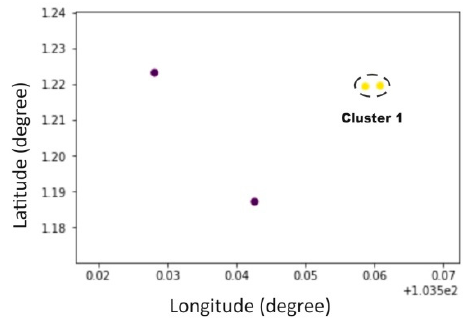
Figure 12. Result of DBSCAN at 1850.